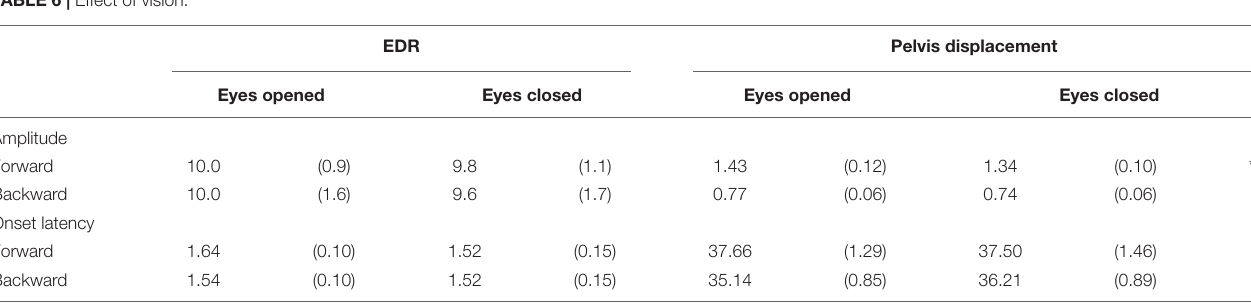
TABLE 6 | Effect of vision.